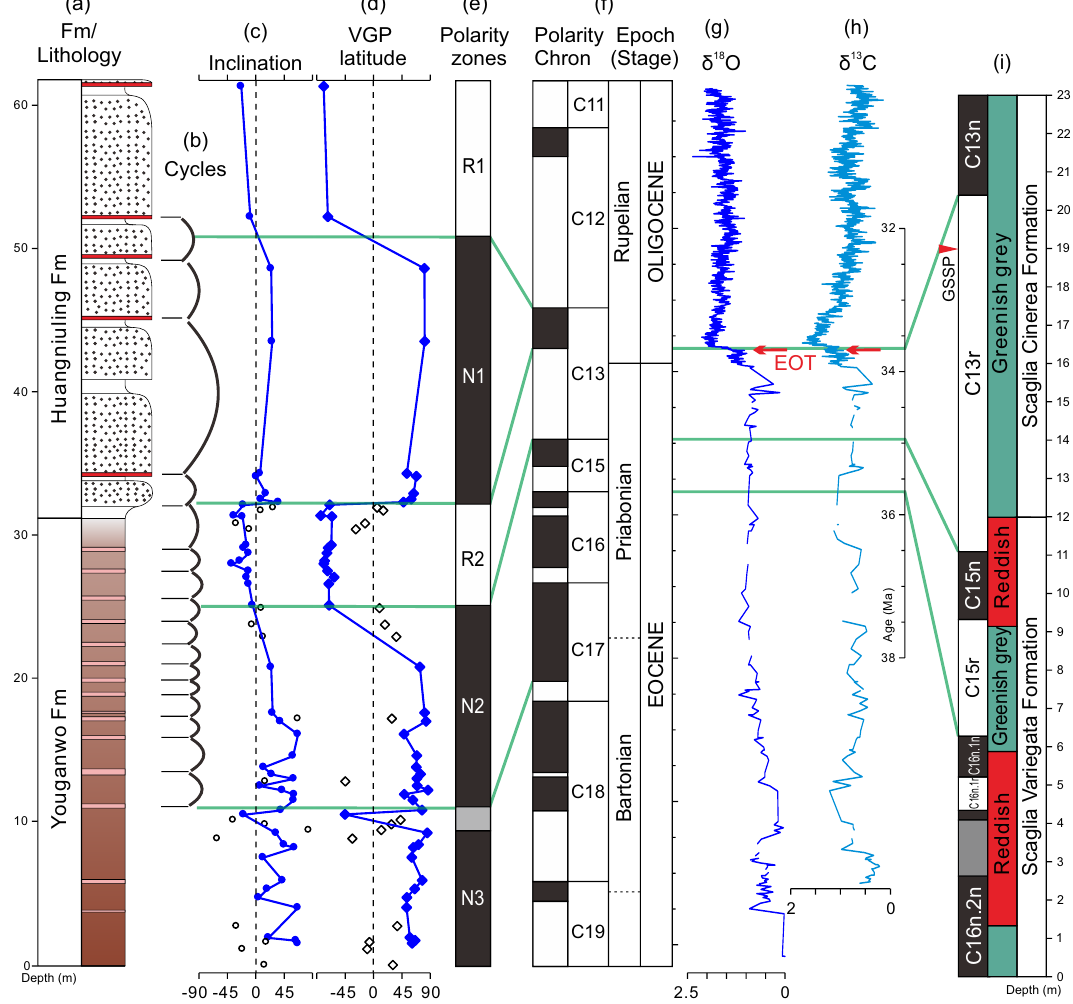
Figure 8. Integrated litho-, cyclo-, and magnetostratigraphy (a–f) of the investigated section, and the correlation with the δ 18 O and δ 13 C records (g, h) from the equatorial Pacific deep-sea sediments (ODP site 1218) (Pälike et al., 2006) as well as the chrono- and lithostratigraphy (i) of the Massignano section in Italy (the Eocene–Oligocene boundary global stratotype section and points, GSSP; Jovane et al., 2009), showing the Eocene–Oligocene climatic transition (EOT) and its precursor events. The legends for lithology and sedimentary cycles of the section studied in the Maoming Basin are the same as those in Fig. 2. In (c, d) the solid (open) symbols represent A (B)-quality ChRM data. Note that a major lithological change from the Scaglia Variegada Fm to the Scaglia Cinerea Fm occurs at 12m, which corresponds to the early stage of chron C13r (i) , while the major lithological change at the investigated section occurs at the late stage of chron C13r (a, f)